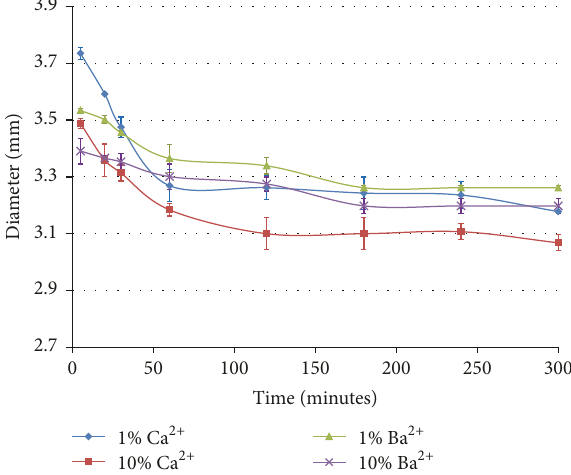
Figure 2: Diameters of alginate beads incubated in different concentrations of Ca 2+ and Ba 2+ at room temperature (25 ∘ C) for various gelling times.